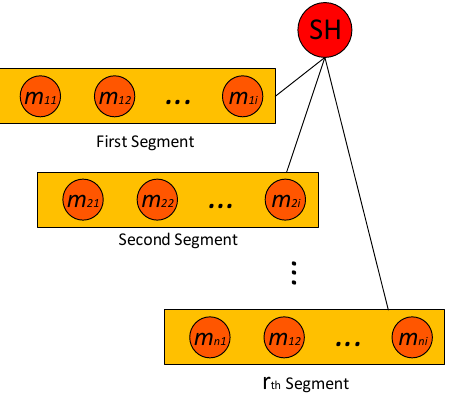
Figure 6. Formation of Segments inside a Sector.